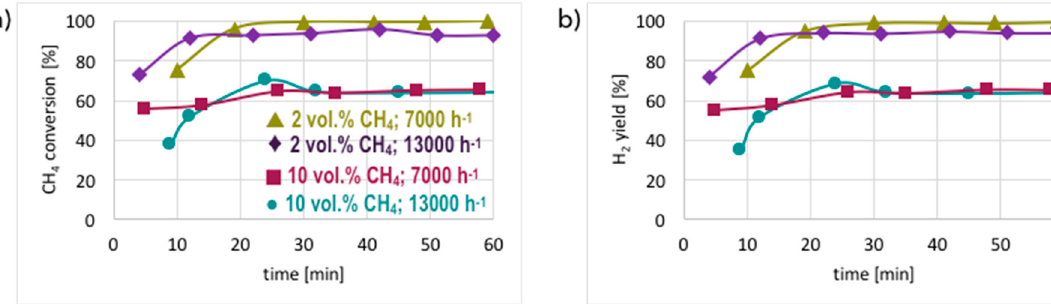
Figure 5. CH 4 conversion ( a ) and H 2 yield ( b ) during tests carried out on unreduced Ni/CeZrO 2 in flowing 2 and 10 vol.% CH 4 /Ar, and at GHSV = 7000 and 13,000 h − 1 .